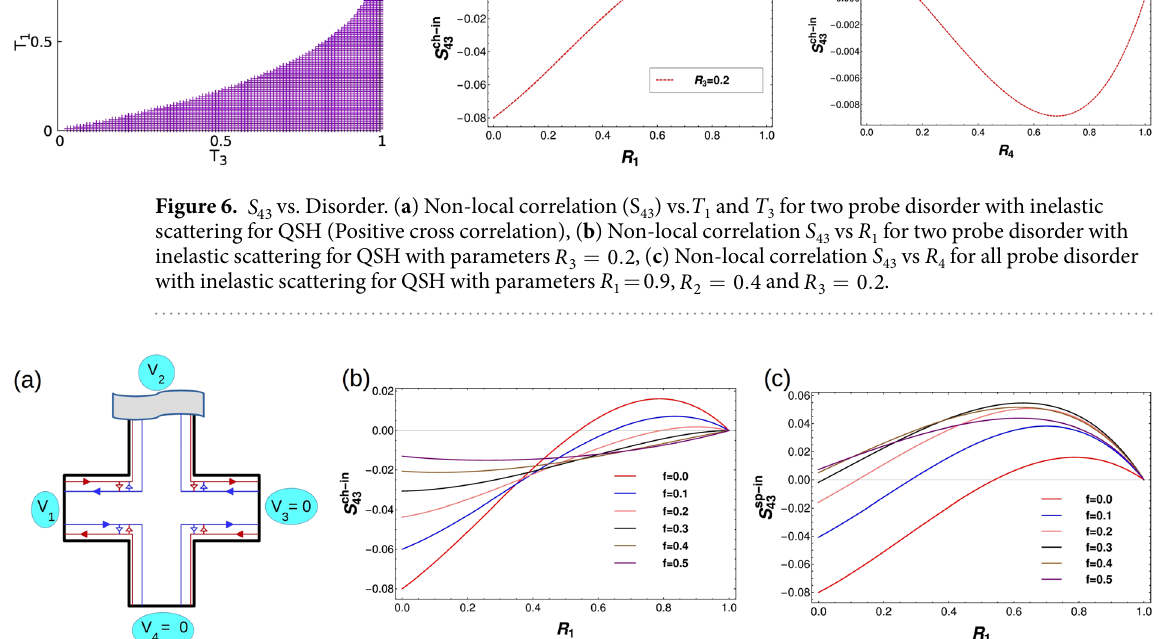
vs R ) and 1 43 ) 3